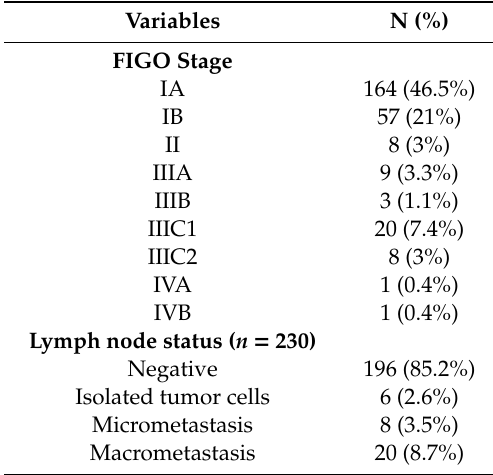
BMI = body mass index. FIGO = International Federation of Gynaecology and